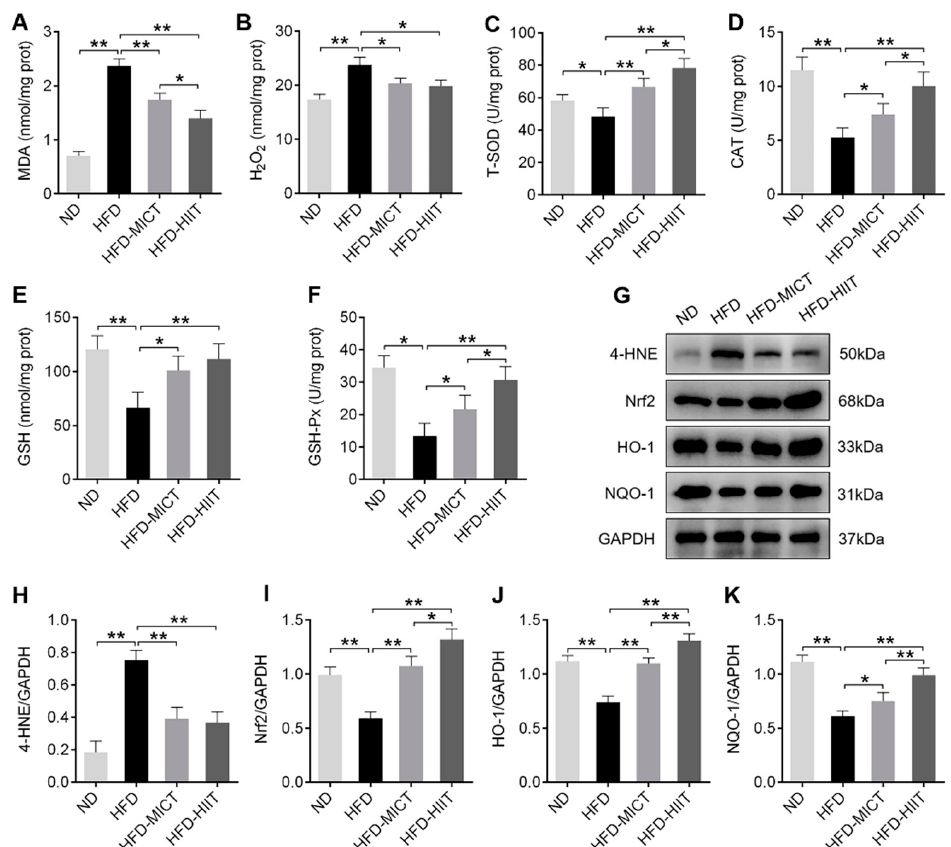
Figure 5. Effects of MICT and HIIT on testicular oxidative stress in obese mice. The activities of ( A ) MDA, ( B ) H 2 O 2 , ( C ) T-SOD, ( D ) CAT, ( E ) GSH and ( F ) GSH-Px in mouse testes. ( G – K ) Protein levels of 4-HNE, Nrf2, HO-1 and NQO-1 were detected by Western blot. Data are expressed as mean ± SEM. * p < 0.05, ** p < 0.01.